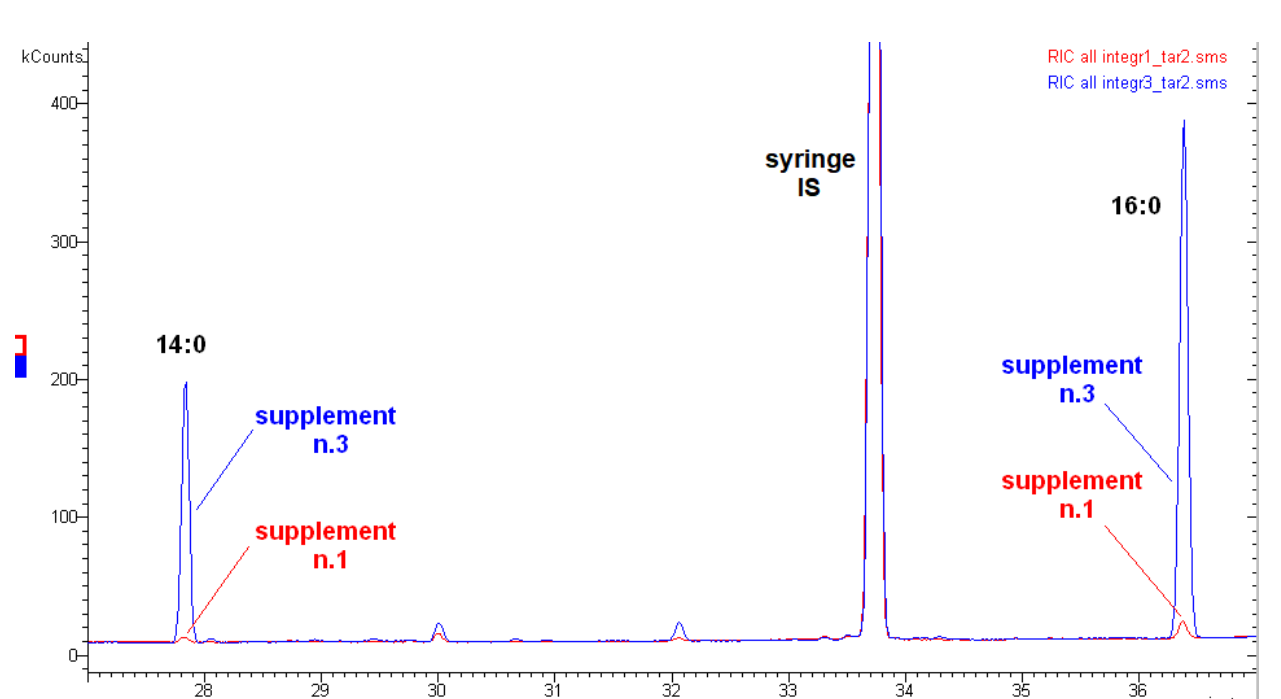
Figure 1. GC-MS chromatograms of supplement no. 1 and supplement no. 3 in full scan mode, time range 27–37 min. Chromatograms are overlaid. “Syringe IS” was added to the vials just before GC-MS injections to check the run-to-run repeatability of the retention times. As “syringe IS”, methylated C15:1 n-5 fatty acid was used.